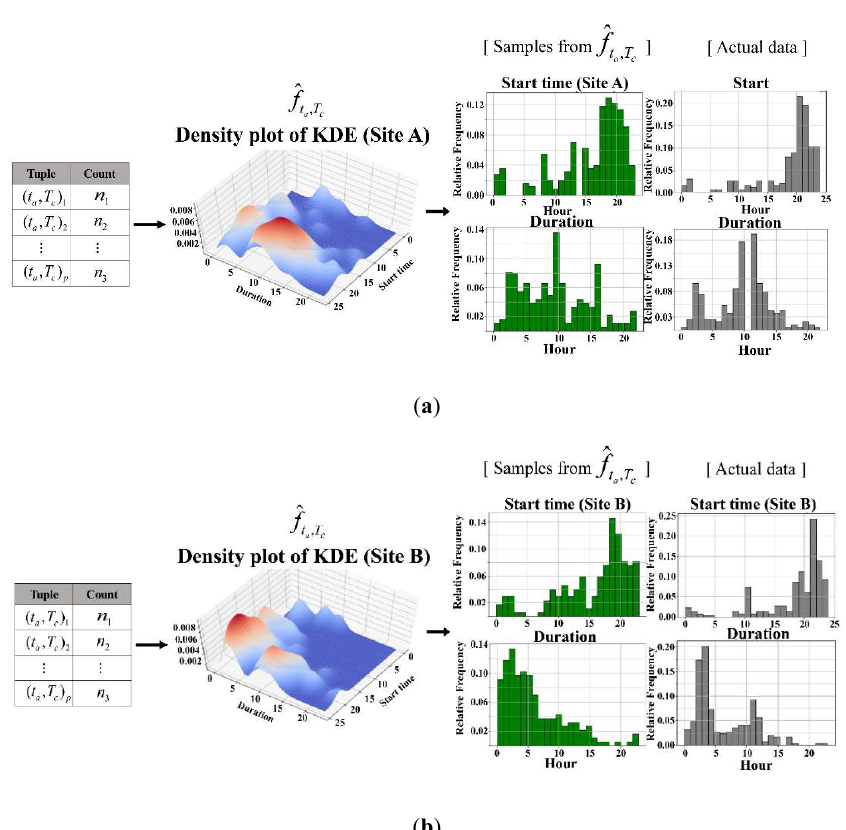
Figure 4. Results of the kernel density estimation (KDE) for probability distributions of tuples of start time of charging and charging duration: ( a ) Site A; ( b ) Site B.